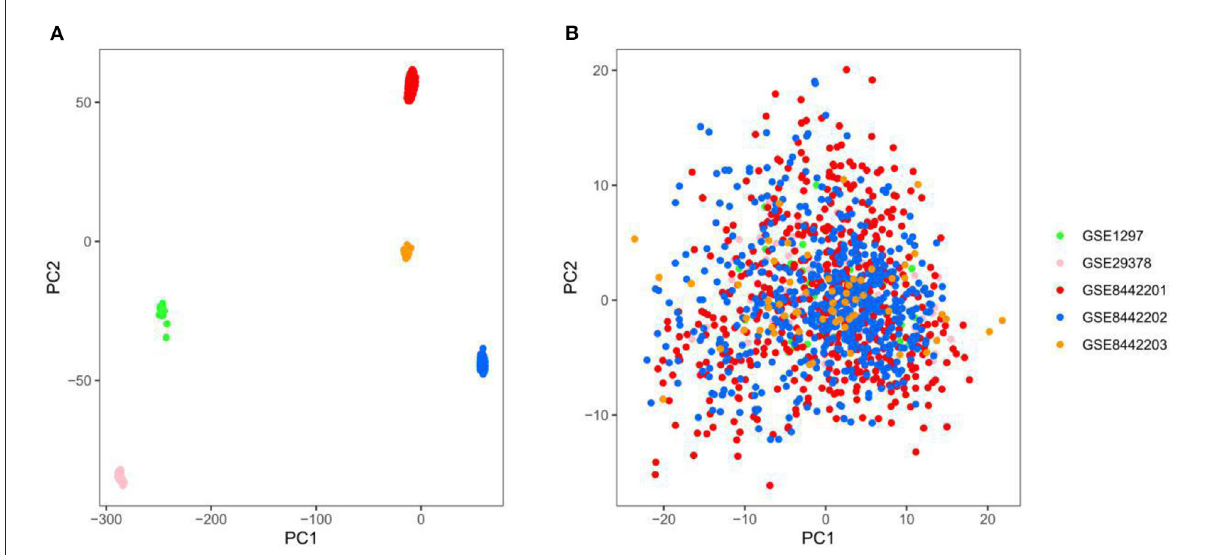
FIGURE2 Principal component analysis (PCA) of the gene expression datasets, different colors represent specific samples. (A) Samples were visualized before removing the batch effect. (B) Samples were visualized after removing the batch effect. GSE1297, n = 31; GSE29378, n = 63;